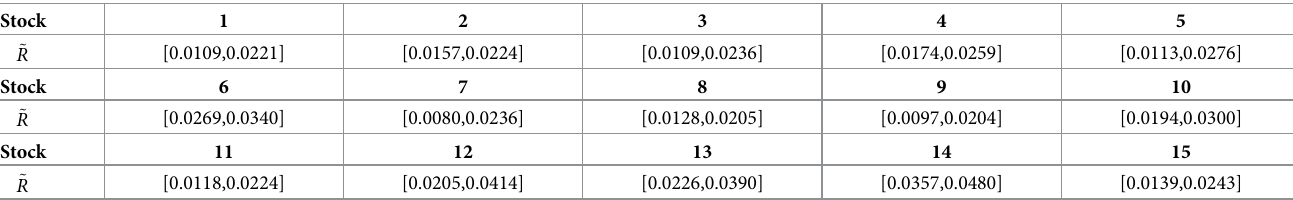
Table 1. The intervals of expected rate of